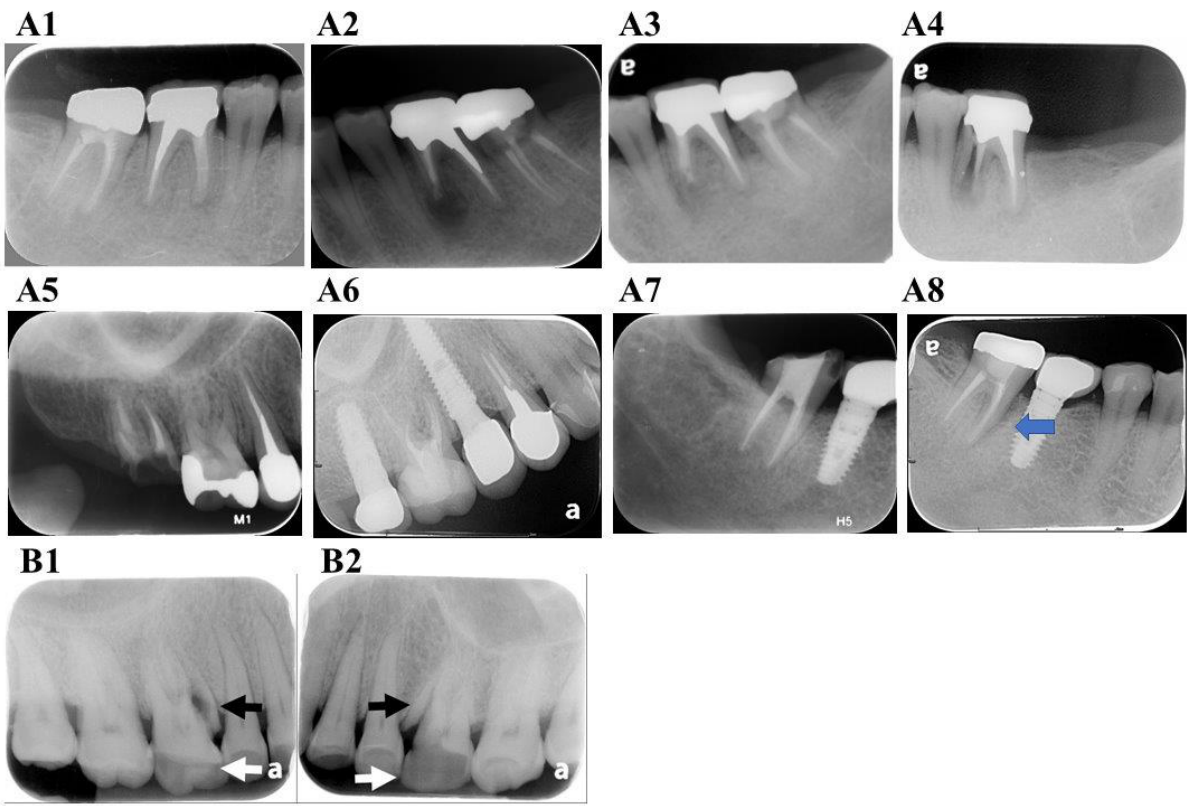
Figure 4. Clinical cases of VRF. ( A1 ) A 31-year-old female patient showed 46 clinical symptoms even after endodontic retreatment and crown fabrication in January 2006. A VRF in the mesial root with deep pocket was noted after surgical exploration. ( A2 ) In the same patient, a periapical radiograph of 36 was taken immediately after apical surgery of the mesial root in December 2011. Apical radiolucency was noted. ( A3 ) Complete healing of apical lesion over the mesial root of 36 in May 2012. ( A4 ) Sinus tract formation and a deep periodontal pocket with VRF of the mesial root of 36 was found in October 2013. ( A5 ) Radiograph picture of 15, 16 and 17 in June 2016. Endodontic retreatment of 17 was completed. Endodontic treatment and crown procedure performed several years ago in the local dental clinic. ( A6 ) Radiograph of the same region in November 2020; 15 and 17 were extracted due to VRFs and replaced with implants during this period. ( A7 ) Endodontic treatment of 47 was completed in May 2013. ( A8 ) VRF of 47 with deep pocket and radiolucency (blue arrow) around the whole mesial root of 47 in November 2020; ( B ) VRFs (black arrows) in non-endodontically treated teeth usually present along with an attrited occlusal surface (white arrows). ( B1 ) 16 and ( B2 ) 26 in the same patient.